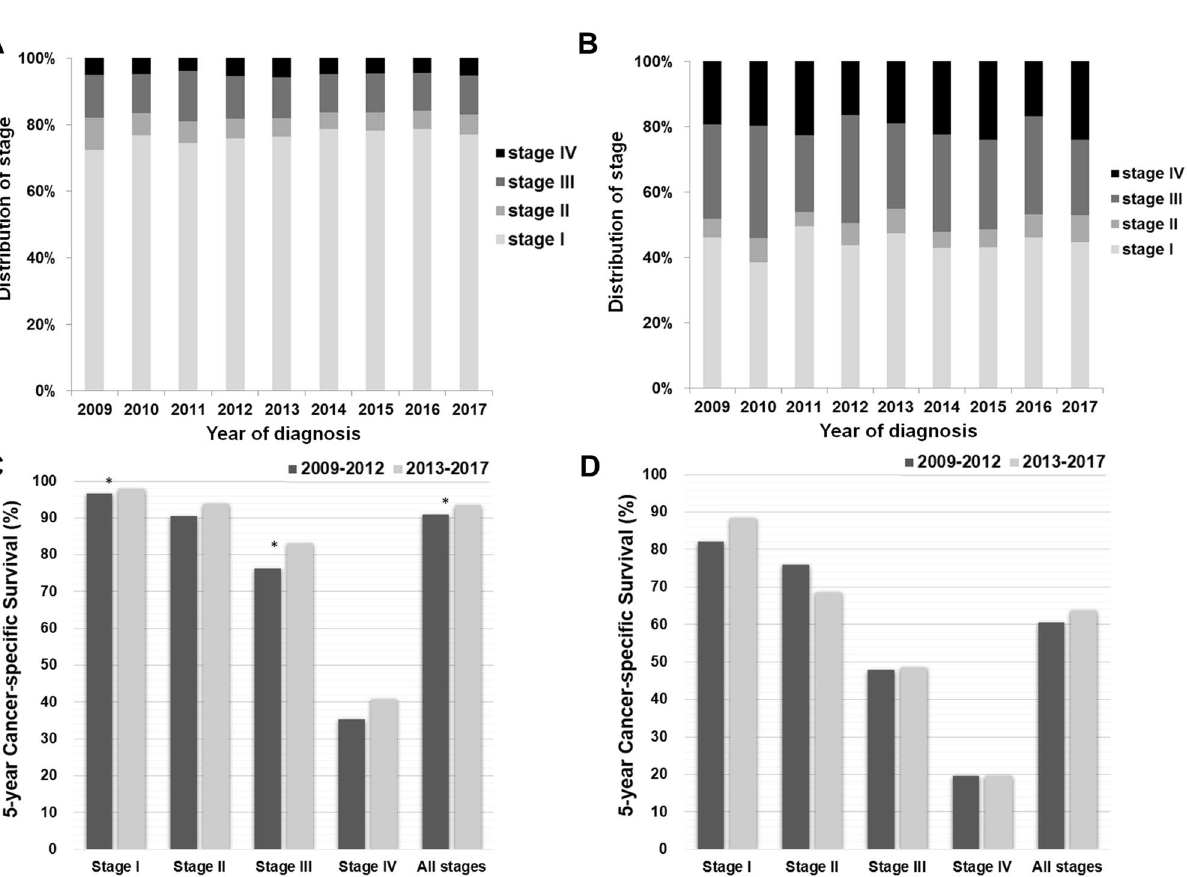
Figure 4. Survival and stage at diagnosis of patients with endometrial cancer in Taiwan. The stages at diagnosis of patients with ( A ) endometrioid and ( B ) nonendometrioid carcinoma between 2009 and 2017. Comparison of 5-year cancer-specific survival rates for the two periods for patients with ( C ) endometrioid and ( D ) nonendometrioid carcinomas by stage. * P <